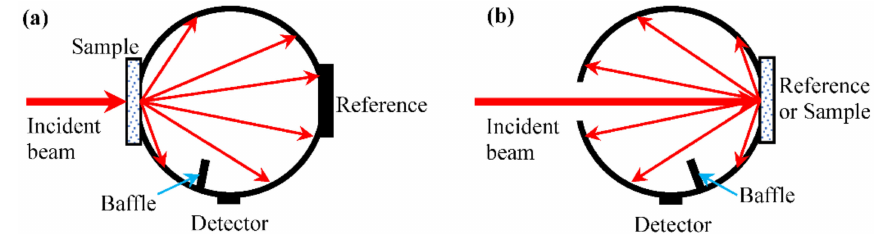
Figure 7. Measurement system [44] diagram of ( a ) direction-hemispherical transmittance and ( b ) direction-hemispherical